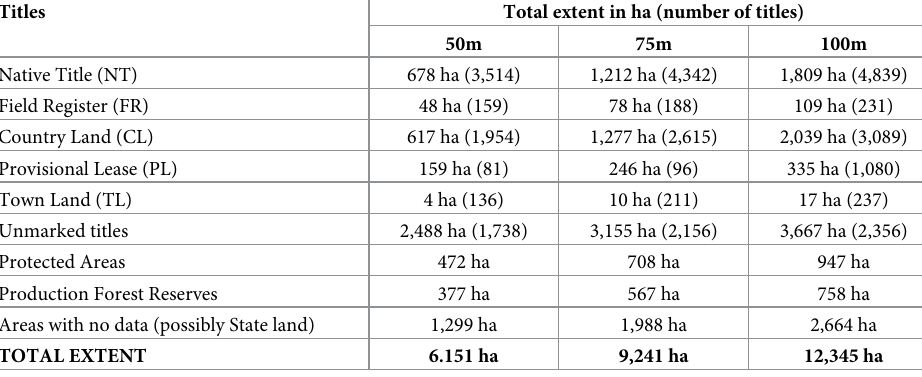
Table 4. Land title types that may be impacted by the Pan Borneo Highway.